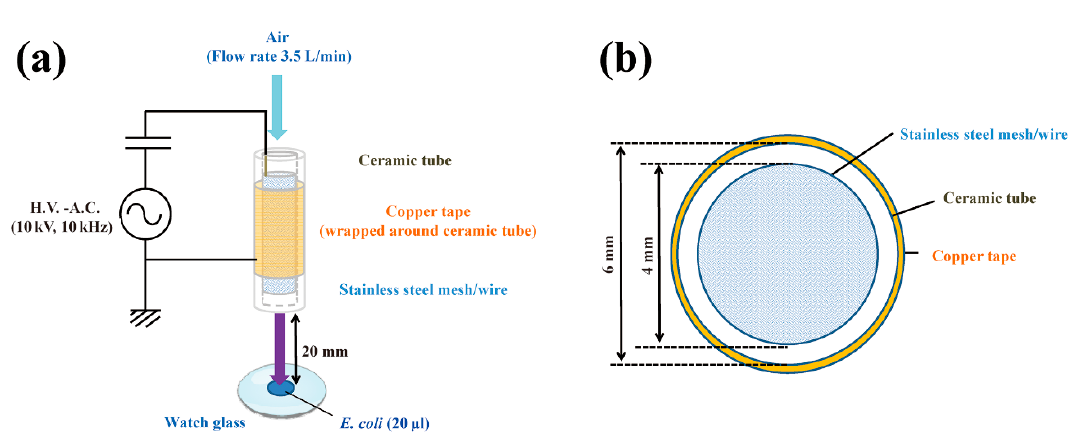
Figure 1. Schematic of a dielectric barrier discharge (DBD) plasma torch. ( a ) The DBD plasma torch comprises a ceramic tube (Al 2 O 3 ) (length, 100 mm) containing a stainless-steel mesh (SUS304) and covered with copper tape (thickness, 80 µ m) on the outside. The copper tape and stainless steel mesh with stainless steel wire were connected to a power supply (10 kV, 10 kHz); ( b ) Cross-sectional view of the torch, which is made up of a ceramic tube (inner diameter, 4 mm; outer diameter, 6 mm). During gas plasma generation, air flow was maintained at 3.5 L / min using an air pump (Suishin SSPP-2S; Suisaku Co., Sakai, Japan). A suspension (20 μ L) of Escherichia coli was dropped onto a watch glass. The distance from the top of the plasma torch to the liquid surface on the watch glass was fixed at 20 mm.